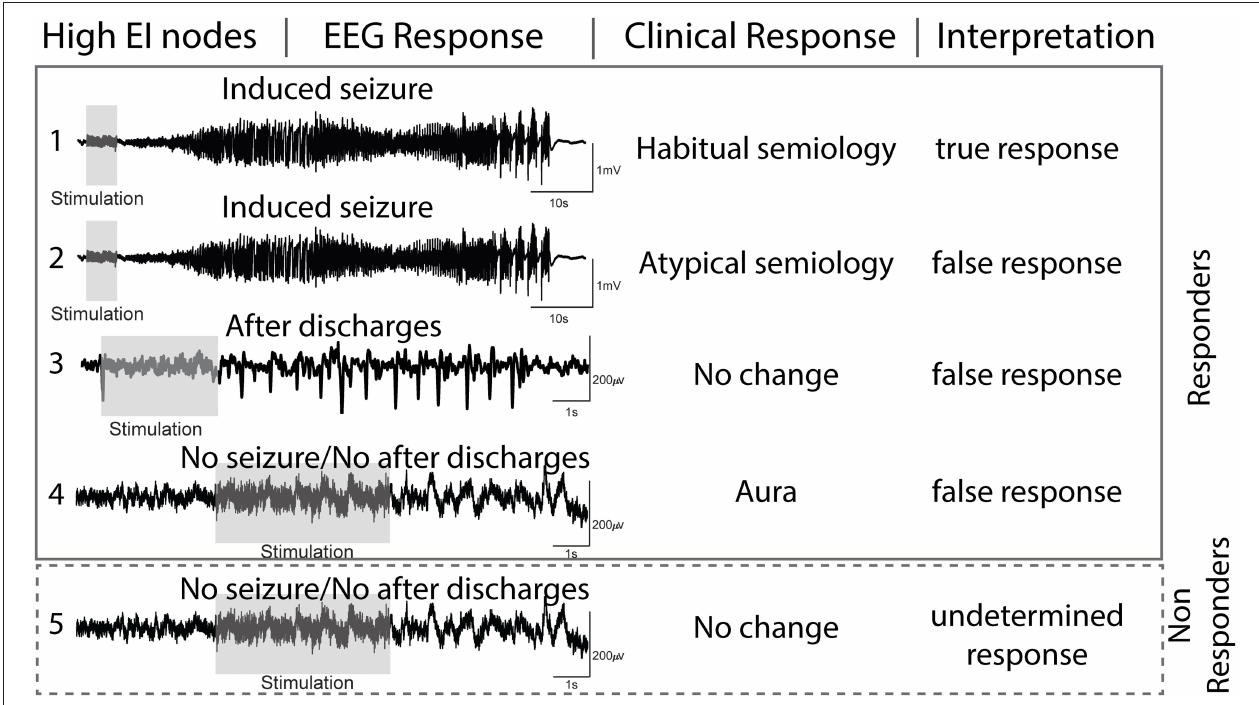
FIGURE 2 | Interpretation of electrographic and clinical responses to direct cortical stimulation (DCS) of nodes with high epileptogenicity index (EI >